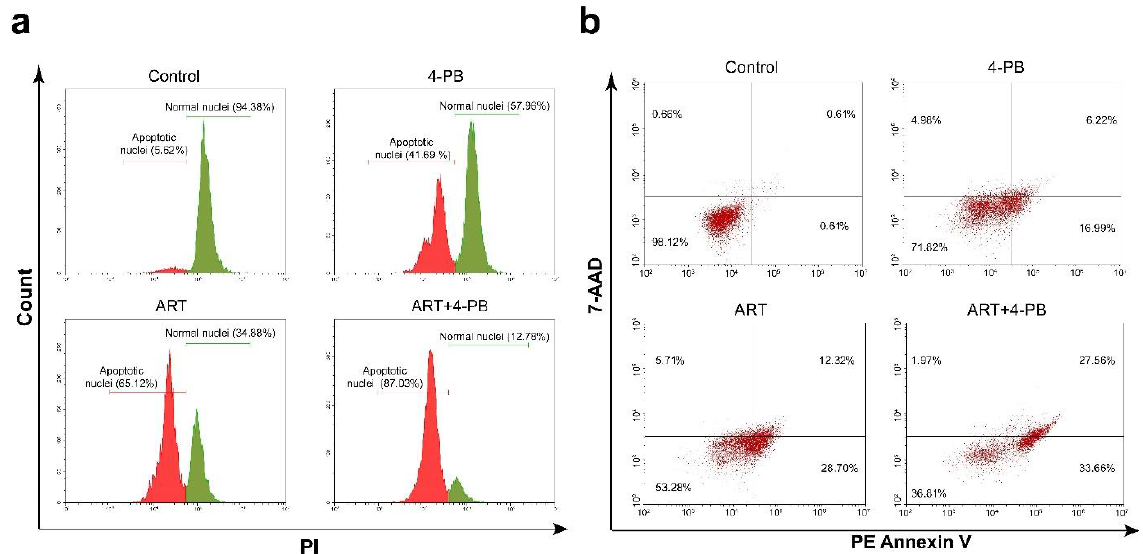
Figure 2. Enhanced cell cytotoxicity of ART in combination with 4-PB was assessed by flow cytometry-based apoptotic assays. ( a ) PI based apoptotic cell analysis using flow cytometer. ( b ) Assessment of early apoptotic (Annexin V), late apoptotic (Annexin V + 7-AAD) and necrotic cells (7-AAD) was performed using PE Annexin V and 7-AAD-based assay. Four distinct populations of cells were produced by the method: healthy cells (Annexin-V negative and 7-ADD negative; lower right quadrant), early apoptotic cells (positive for Annexin-V and negative for 7-ADD; lower right corner), late apoptotic/dead cells (both Annexin V and 7-ADD positive; upper right quadrant), and necrotic cells (only 7-ADD positive).